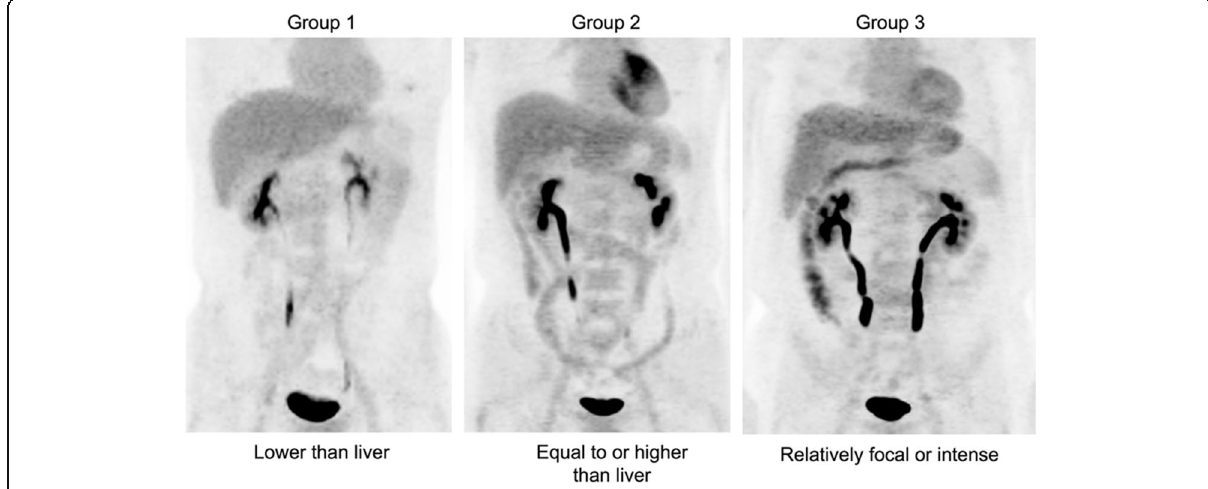
Fig. 1 Intestinal 18 F-FDG uptakes classified by visual